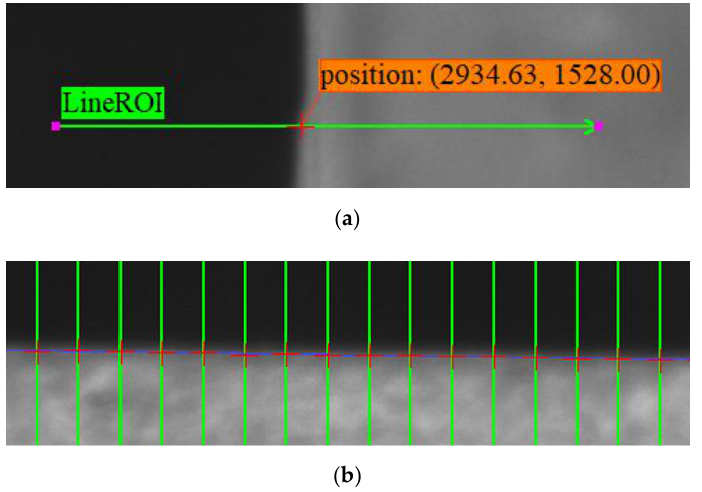
Figure 9. Schematic diagram of the extraction effect of edge feature points: ( a ) extraction of edge feature points using Line ROI and getting the coordinates of the edge points under the image coordinate system; ( b ) the effect of edge point extraction in the flat area of the track plate using Rake ROI.